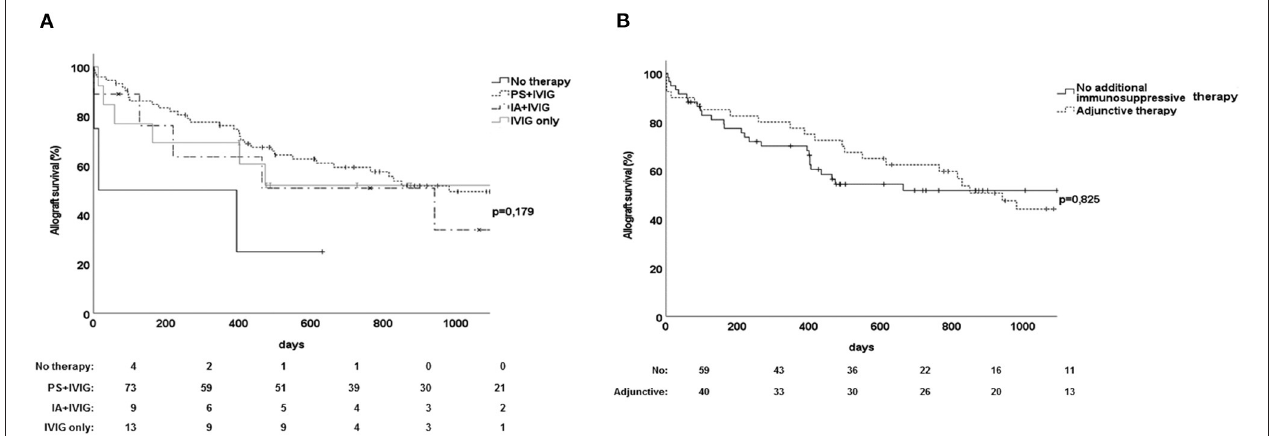
FIGURE 3 | Effect of various treatment approaches on renal allograft survival among 102 recipients with antibody-mediated rejection. (A) Comparison between the use of plasmapheresis plus IVIG vs. immunoadsorption with IVIG and IVIG alone. (B) Effect on renal allograft survival of the administration of adjunctive immunosuppressive drugs in addition to standard therapy among recipients with ABMR. Adjunctive immunosuppressive drugs were rituximab ( n = 10), bortezomib ( n = 11), thymoglobulin ( n = 9), or eculizumab ( n = 3). ABMR, antibody-mediated rejection; IA, immunoadsorption; IVIG, intravenous immune globulin; PS, plasmapheresis.